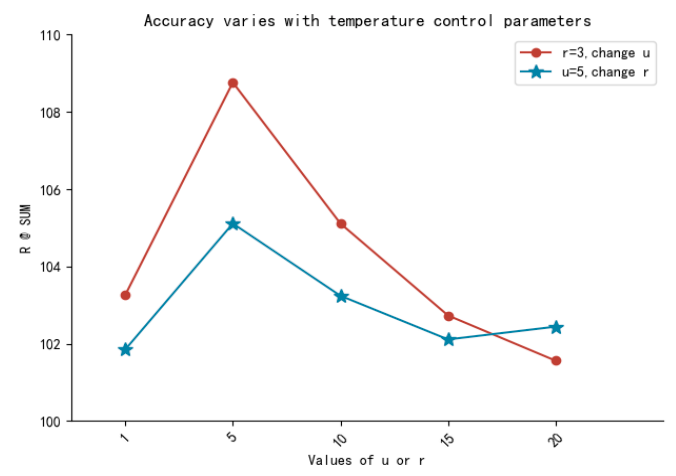
Figure 8. Variations of model precision with temperature control parameters.